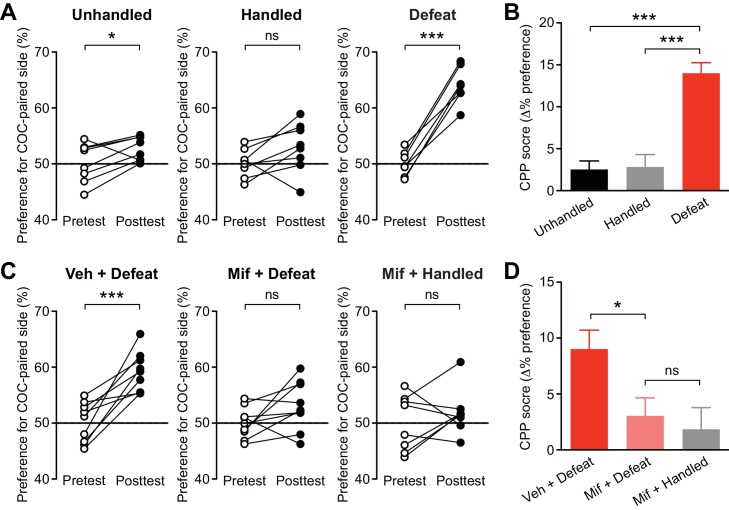
Social defeat promotes cocaine-induced CPP via a GR-dependent mechanism.(A) Summary of changes in the preference for the cocaine-paired side following 1-day conditioning in unhandled, handled, and defeated rats (unhandled: t7 = 2.51, p<0.05; handled: t7 = 1.90, p=0.10; defeat: t6 = 11.0, p<0.001; paired t-test). (B) Summary of 1-day cocaine CPP scores in unhandled, handled, and defeated rats (F2,20 = 25.2, p<0.001, one-way ANOVA). ***p<0.001 (Bonferroni post hoc test). (C) Summary of changes in the preference for the cocaine-paired side following 1-day conditioning in rats pretreated with vehicle or mifepristone 30 min prior to social defeat or handling sessions (vehicle + defeat: t8 = 5.30, p<0.001; mifepristone + defeat: t8 = 1.90, p=0.09; mifepristone + handled: t7 = 0.95, p=0.37; paired t-test). (D) Summary of 1-day cocaine CPP scores in the 3 groups shown in panel C (F2,23 = 4.90, p<0.05, one-way ANOVA). *p<0.05 (Bonferroni post hoc test). None of the treatments in this figure affected the overall activity level during the pretest (Figure 7—figure supplement 2).